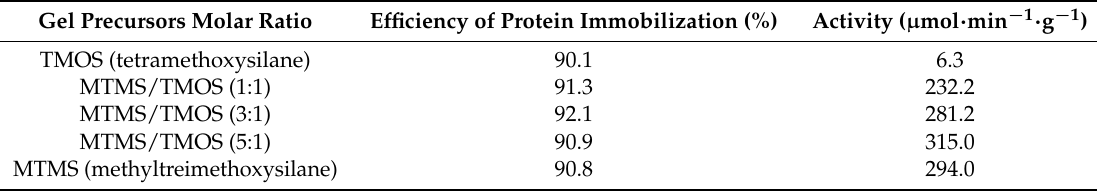
Table 1. The activity of the immobilized lipase derived from different molar ratio of silanes. Gel Precursors Molar